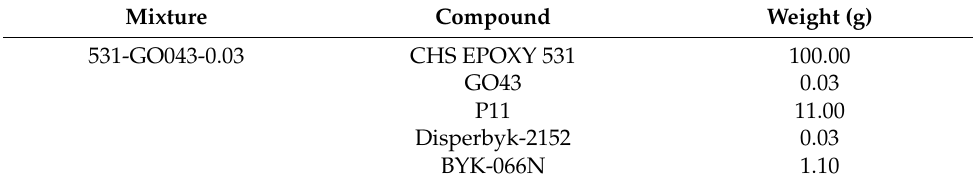
Table A14. Graphene oxide GO43 CHS Epoxy 531, 0.03 phr.